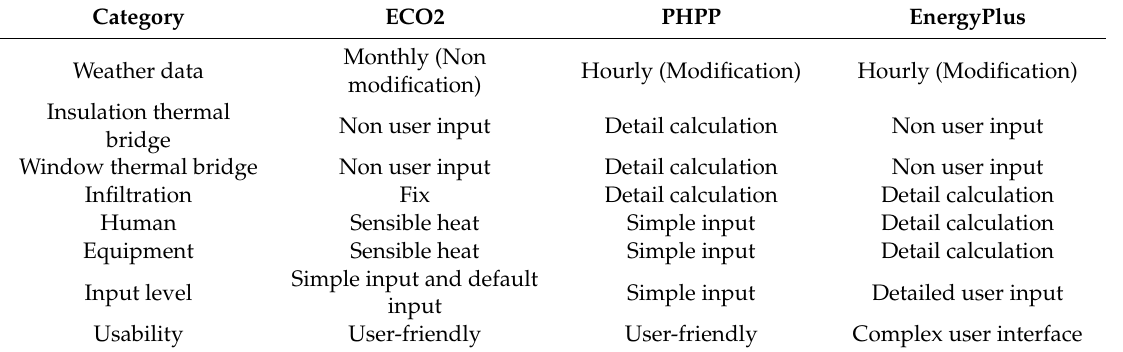
Table 1. Features of ECO 2, PHPP and